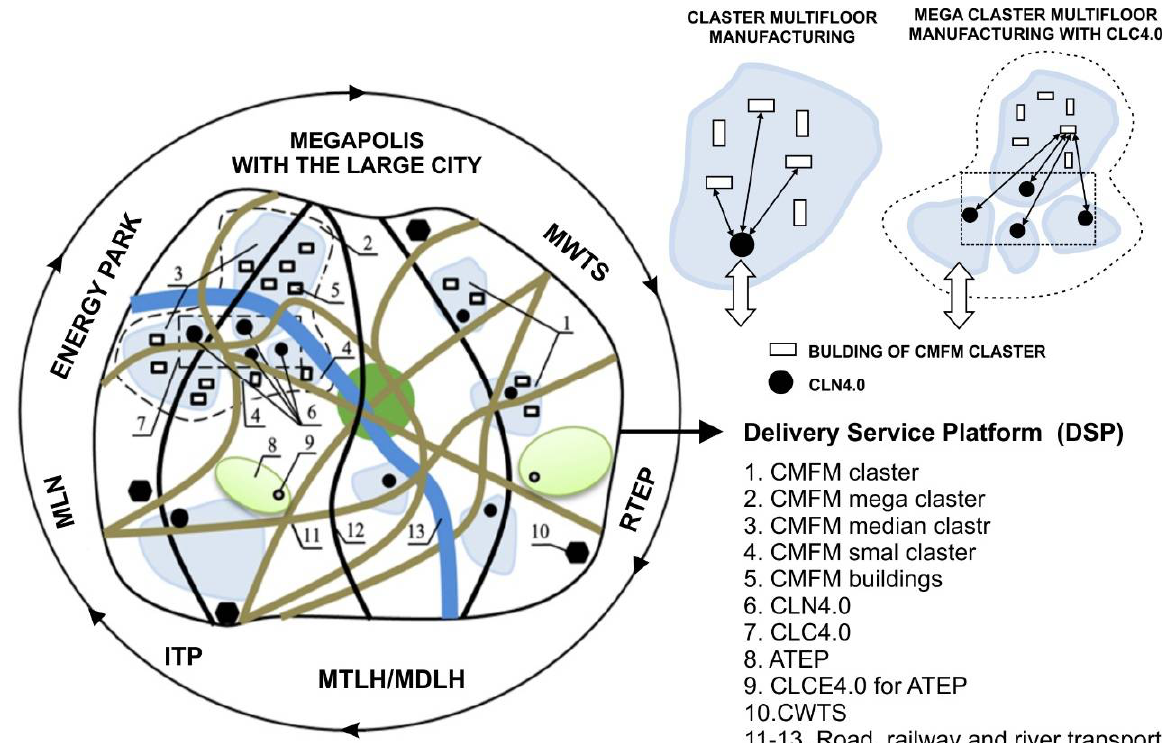
Figure 1. CMFM clusters with CLN4.0 in the structure of a large city and megapolis.